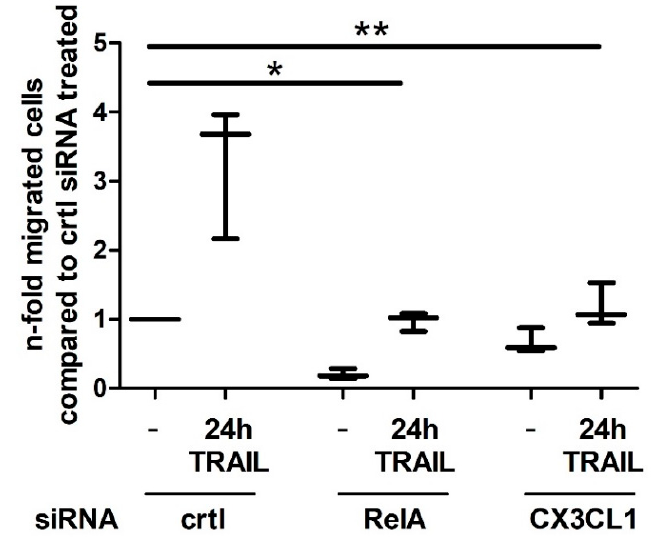
Figure 5. TRAIL induced PBMC migration is RelA and CX3CL1 dependent. PBMCs from healthy donors were isolated and subjected to migration assays. In a transwell system PBMCs were seeded into matrigel coated inserts and migration in dependence of the indicated Panc1 supernatants was measured. Plot from 3 independent measurements show the median (horizontal bar), the whiskers represent the minimum/ maximum data. * p -value < 0.025; ** p -value < 0.05.